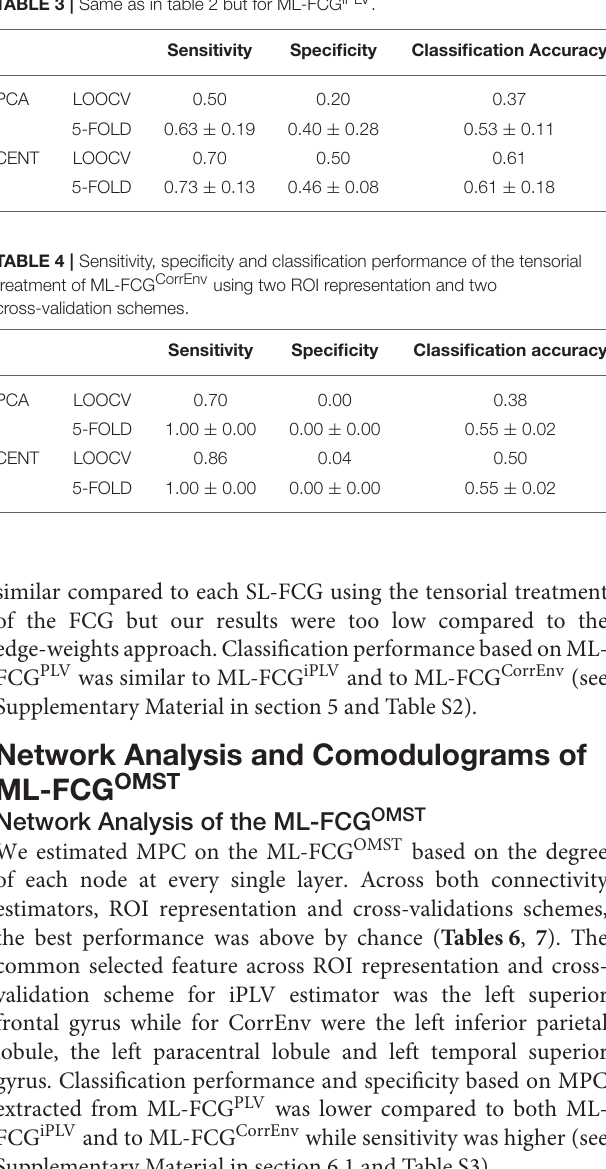
TABLE 3 | Same as in table 2 but for ML-FCG iPLV .